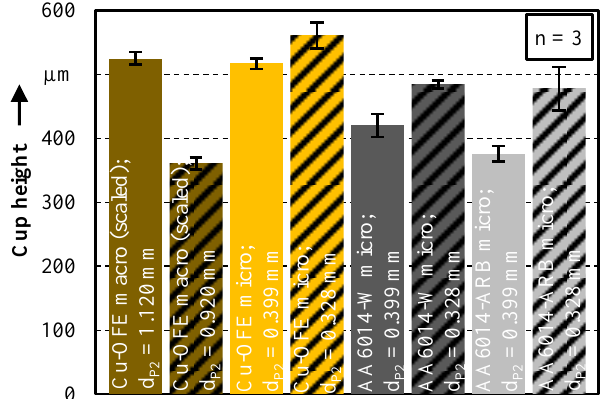
Figure 5. Resulting cup heights in macro (scaled) and micro scale after extrusion stage 2.